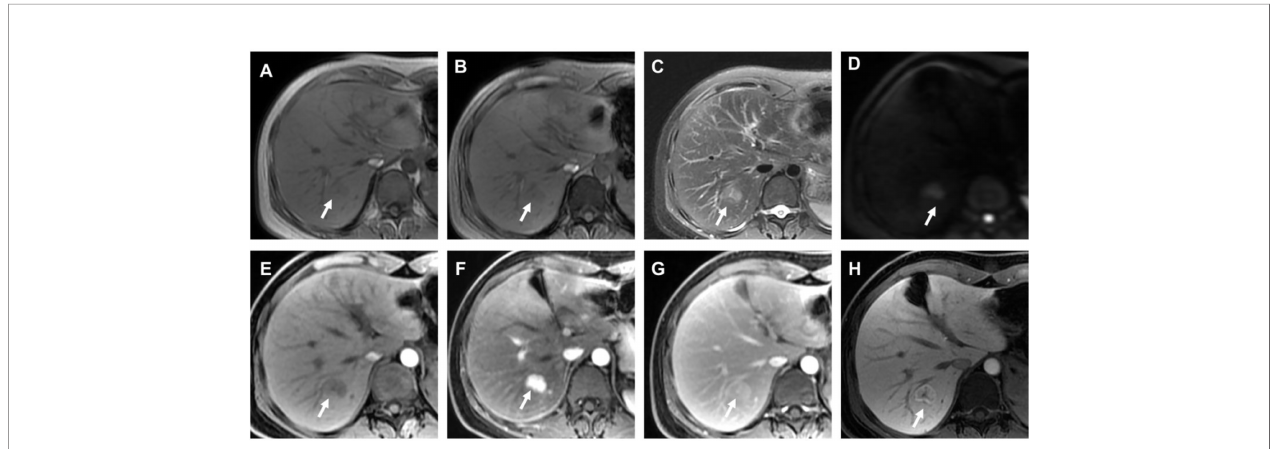
FIGURE 3 | Histopathological con fi rmed FNH with the size of 2.7 cm. The HBSC-MRI showed an isointense to slightly hypointensity nodule in T1-weighted images in-phase [arrow in (A) ] and out-phase [arrow in (B) ] in liver segment VII. This focal liver lesion demonstrated slightly hyperintensity in the T2-weighted image [arrow in (C) ], and with diffusion restriction [arrow in (D) ]. The nodule showed hypointense on pre-contrast images (E) , strongly hyperenhancement in the arterial phase (F) , and isointense compared with normal liver parenchyma in the portal venous phase (G) . The hepatobiliary phase [arrow in (H) ] clearly showed the nodule hyperintensity. The fi nal MRI diagnosis of different criteria (excluding “ DWI + T2WI ” ) was a FNH, con fi rmed by histology after resection.